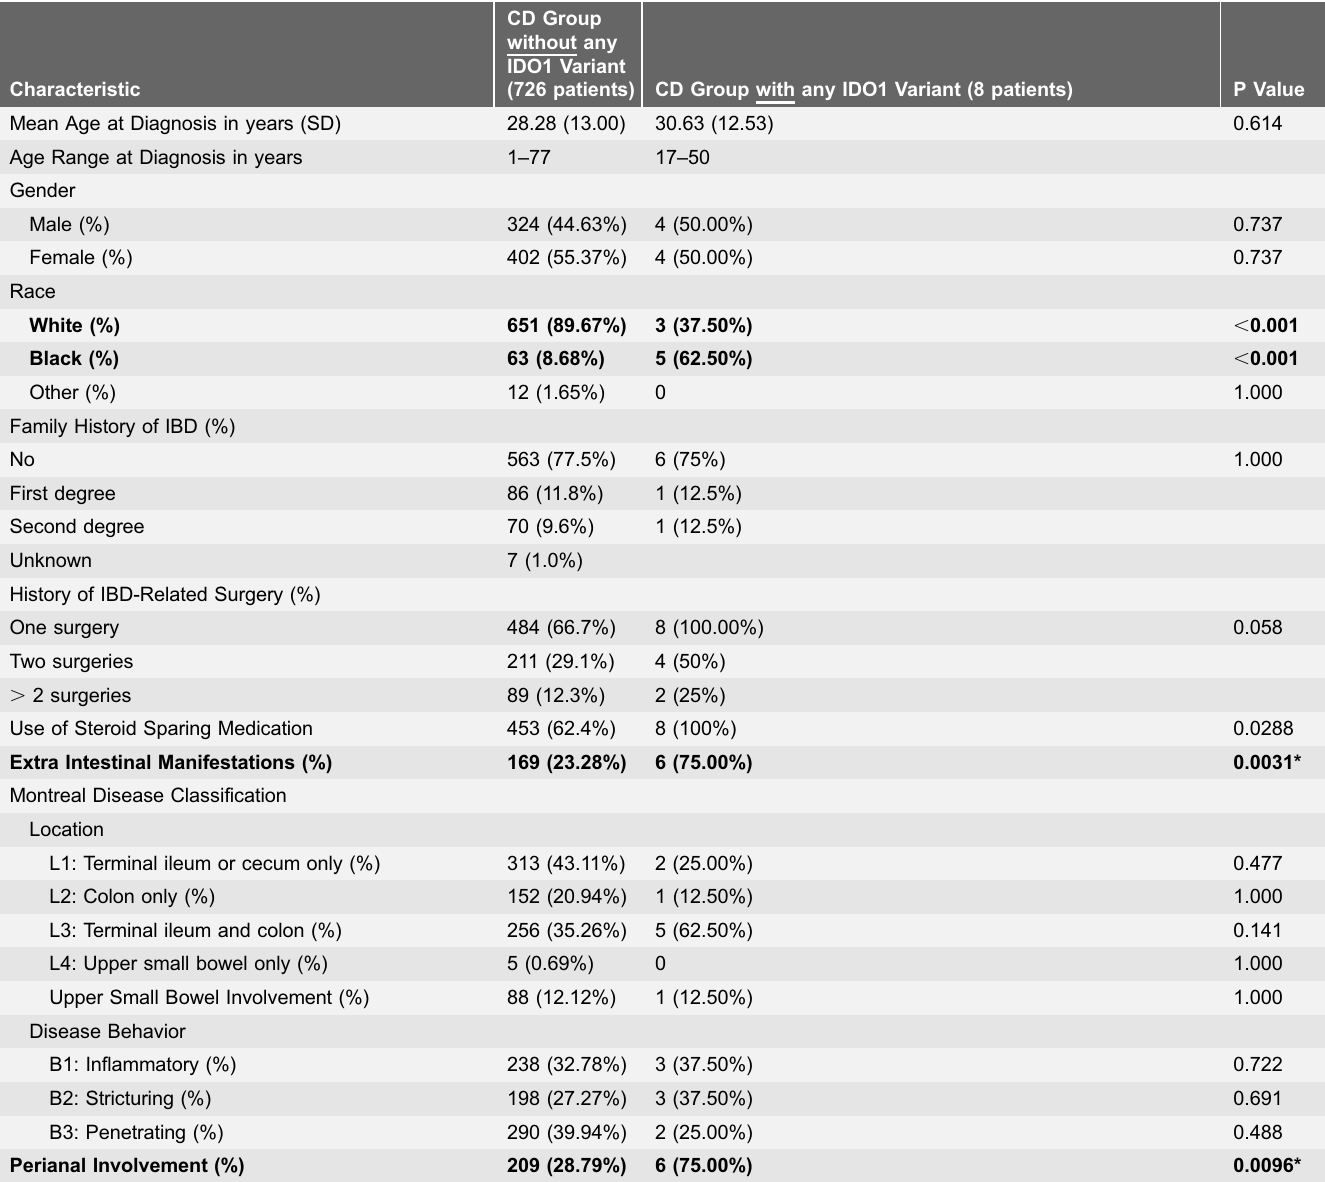
Table 3. IDO1 Variants and Crohn’s Disease